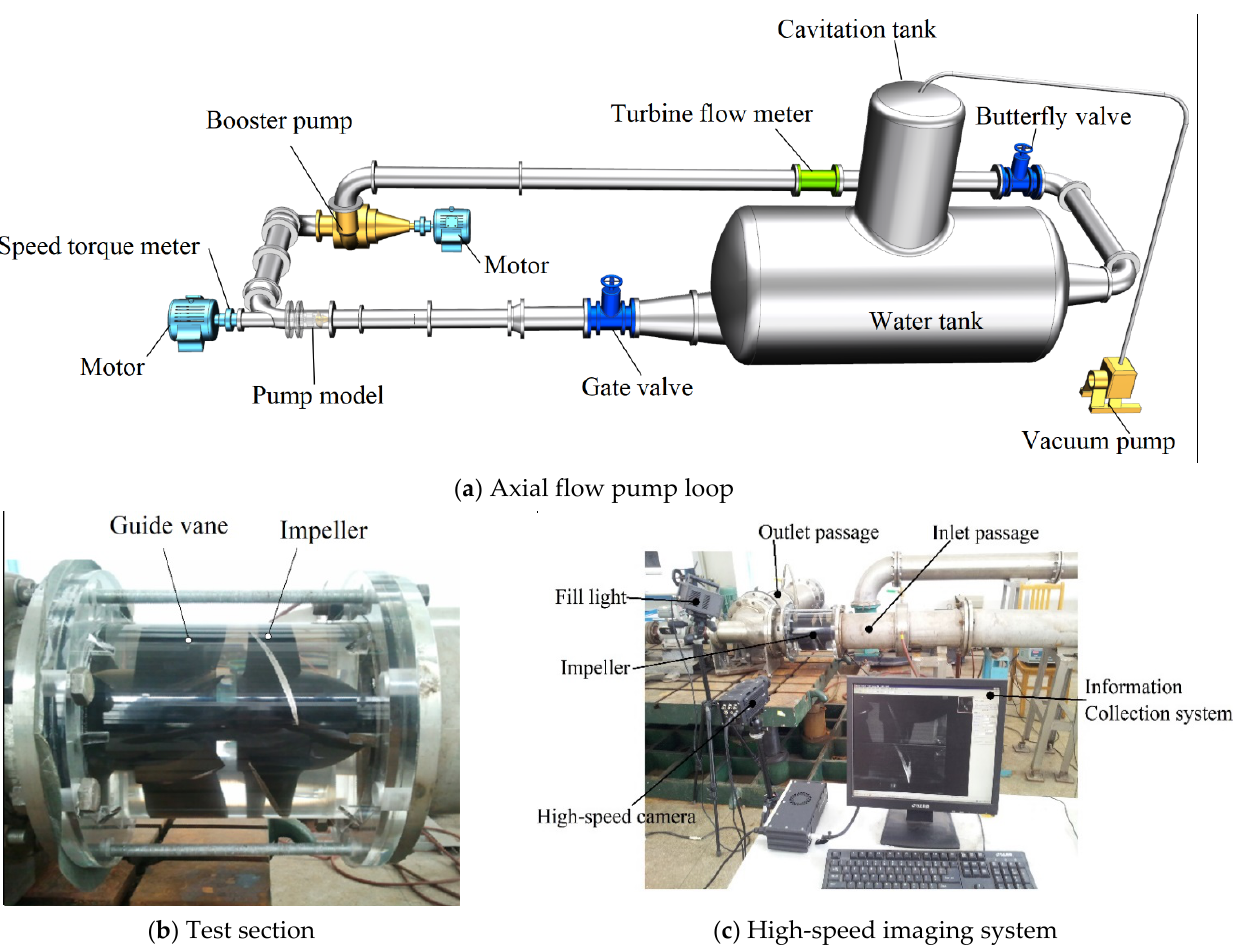
Figure 4. ( a – c ) Experimental equipment for external characteristic and cavitation of the axial flow pump.